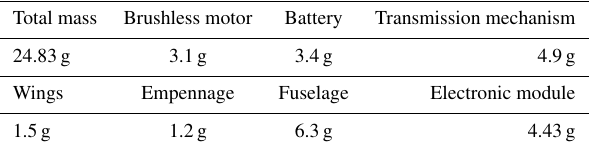
wings area, and maximum flapping frequency are 27.8 cm, Table 2. The detail mass of FWMAV components.